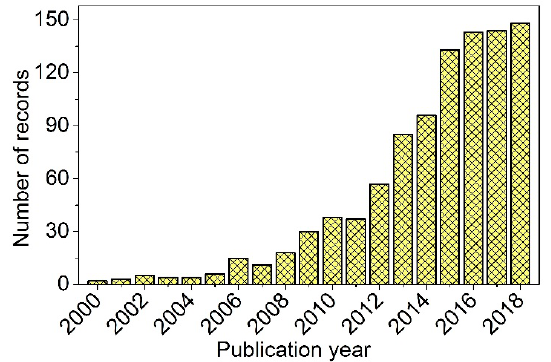
Figure 1. Evolution of the number of publications published per year obtained from literature searching using “natural dye” and “solar cell” topics (data source ISI Web of Science).